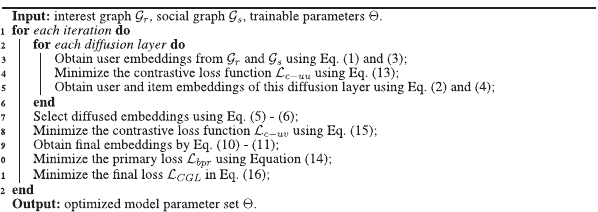
Algorithm 1. The training process of